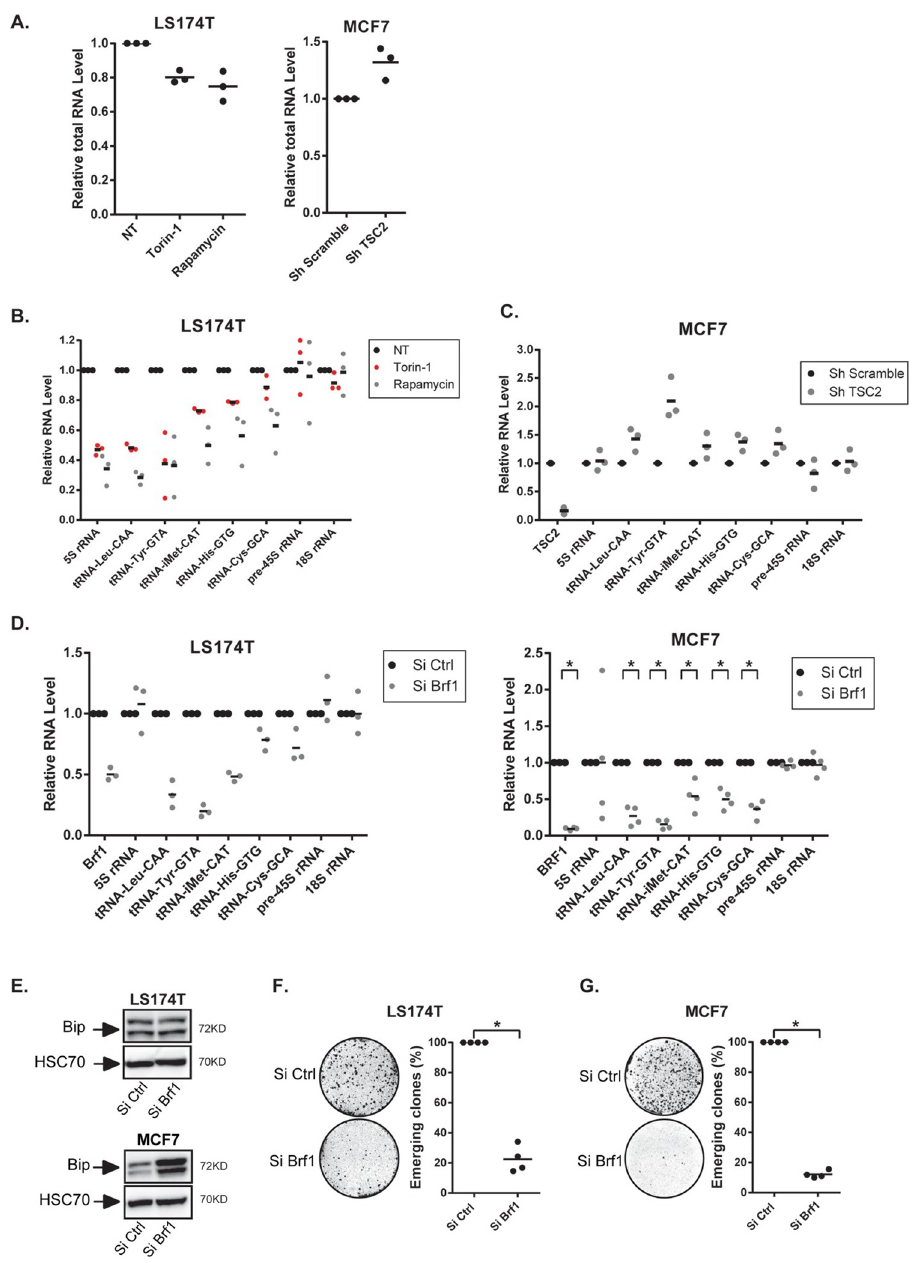
Fig 3. mTOR regulates RNA Pol III activity during CIS escape. A. Nanodrop quantification of total RNA level in senescent LS174T cells two days after mTOR inhibition (left, n = 3) or in senescent MCF7 cells two days after TSC2 inhibition (right, n = 3). B. Senescent LS174T cells were treated with mTOR inhibitors, and the relative expression of the indicated RNA was analyzed by RT-QPCR after 7 days (n = 3). C. Analysis of the expression of the indicated RNAs 2 days after TSC2 depletion in MCF7 senescent cells by RT-QPCR (n = 3). D. Senescent LS174T and MCF7 cells were transfected with a control siRNA or a siRNA directed against Brf1 during 24 hr and then washed with PBS and stimulated with fresh media. Cell extracts were recovered 2 days after Brf1 depletion and the expression of the indicated RNAs was analyzed by RT-QPCR (LS174T: n = 3; MCF7: n = 4, Kolmogorov-Smirnov test, � = p < 0.05). E. Analysis of Bip expression by western blot 7 days after BRF1 depletion in LS174T and MCF7 senescent cells (n = 3). F, G. Senescent LS174T and MCF7 cells were transfected with a control siRNA or a siRNA directed against Brf1 during 24 hr and then washed with PBS and stimulated with fresh media. Nine days after Brf1 inactivation, the number of emerging clones was analyzed (n = 4, Kolmogorov-Smirnov test, � = p < 0.05).